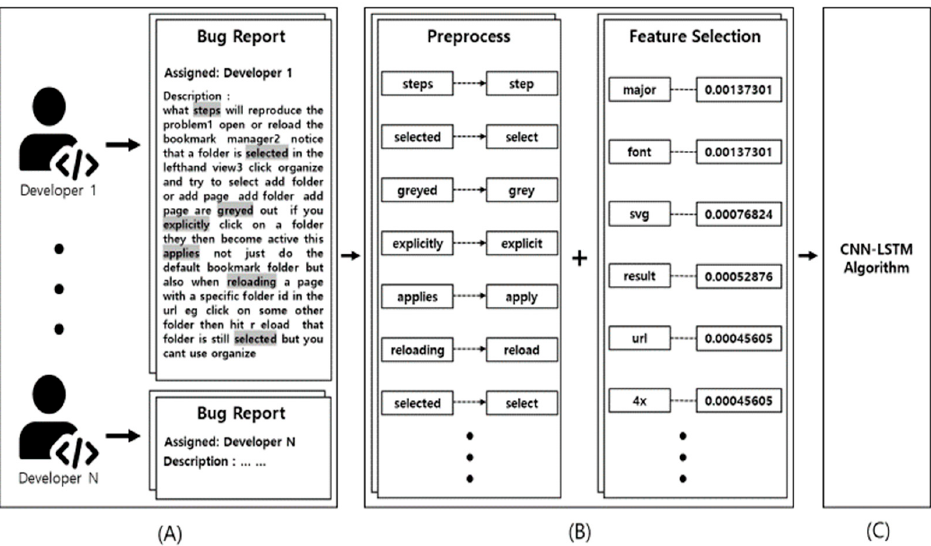
Figure 5. An example of developer-based feature selection.